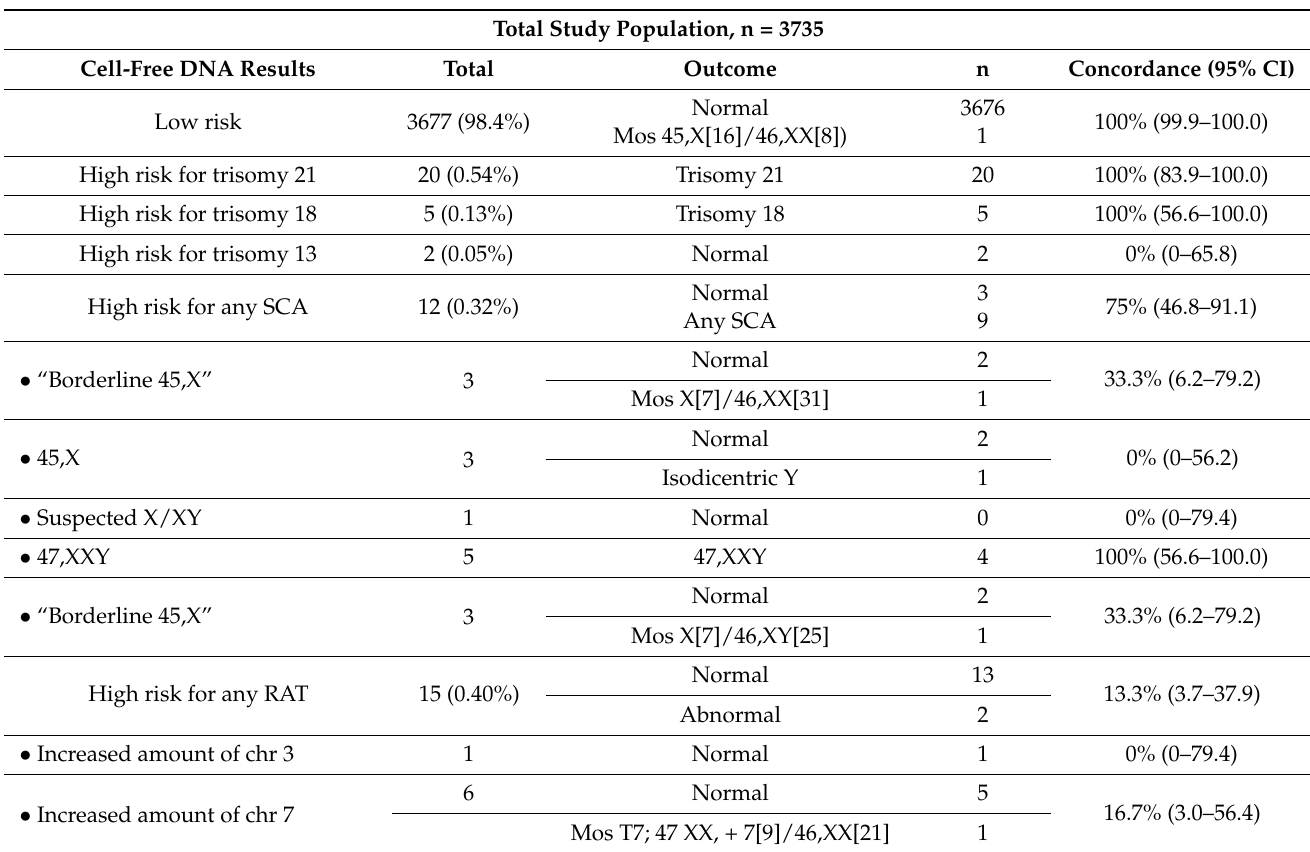
Table 1. Concordance rates between cfDNA test results and